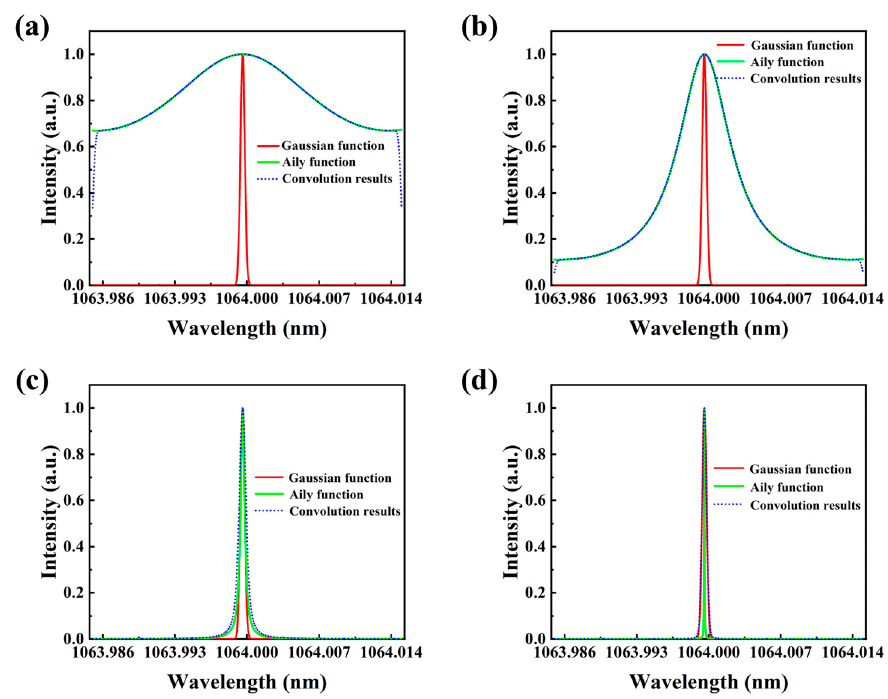
Figure 5. Comparison of Gaussian function, Airy function, and their convolution results under different reflectance: ( a ) R = 10%, ( b ) R = 50%, ( c ) R = 95%, and ( d ) R = 99.5%.